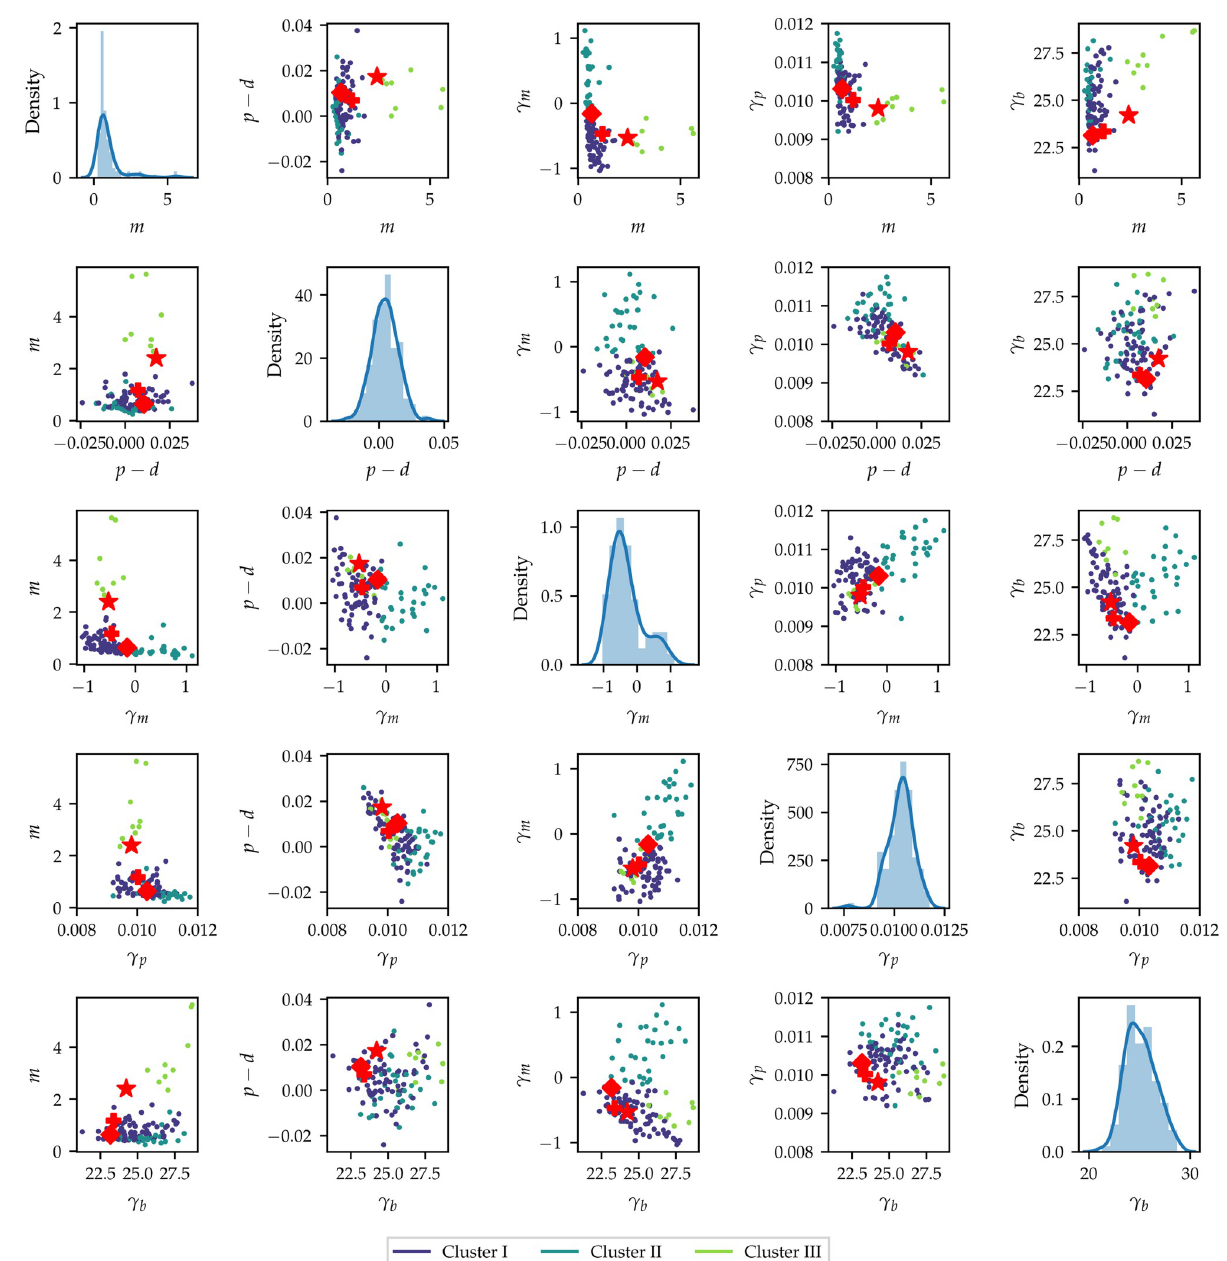
Fig 6. Pairwise distributions of the posterior means for each of the knockdown experiments in the high-throughput screen. Diagonal plots show the distribution of the posterior means of each of the parameters, while off-diagonal plots show the pairwise distributions of the different knockdown posterior means. The colour key denotes the different clusters found using K -means clustering with K = 3. Star denotes Mock, diamond CDC42 knockdown and plus CDH5